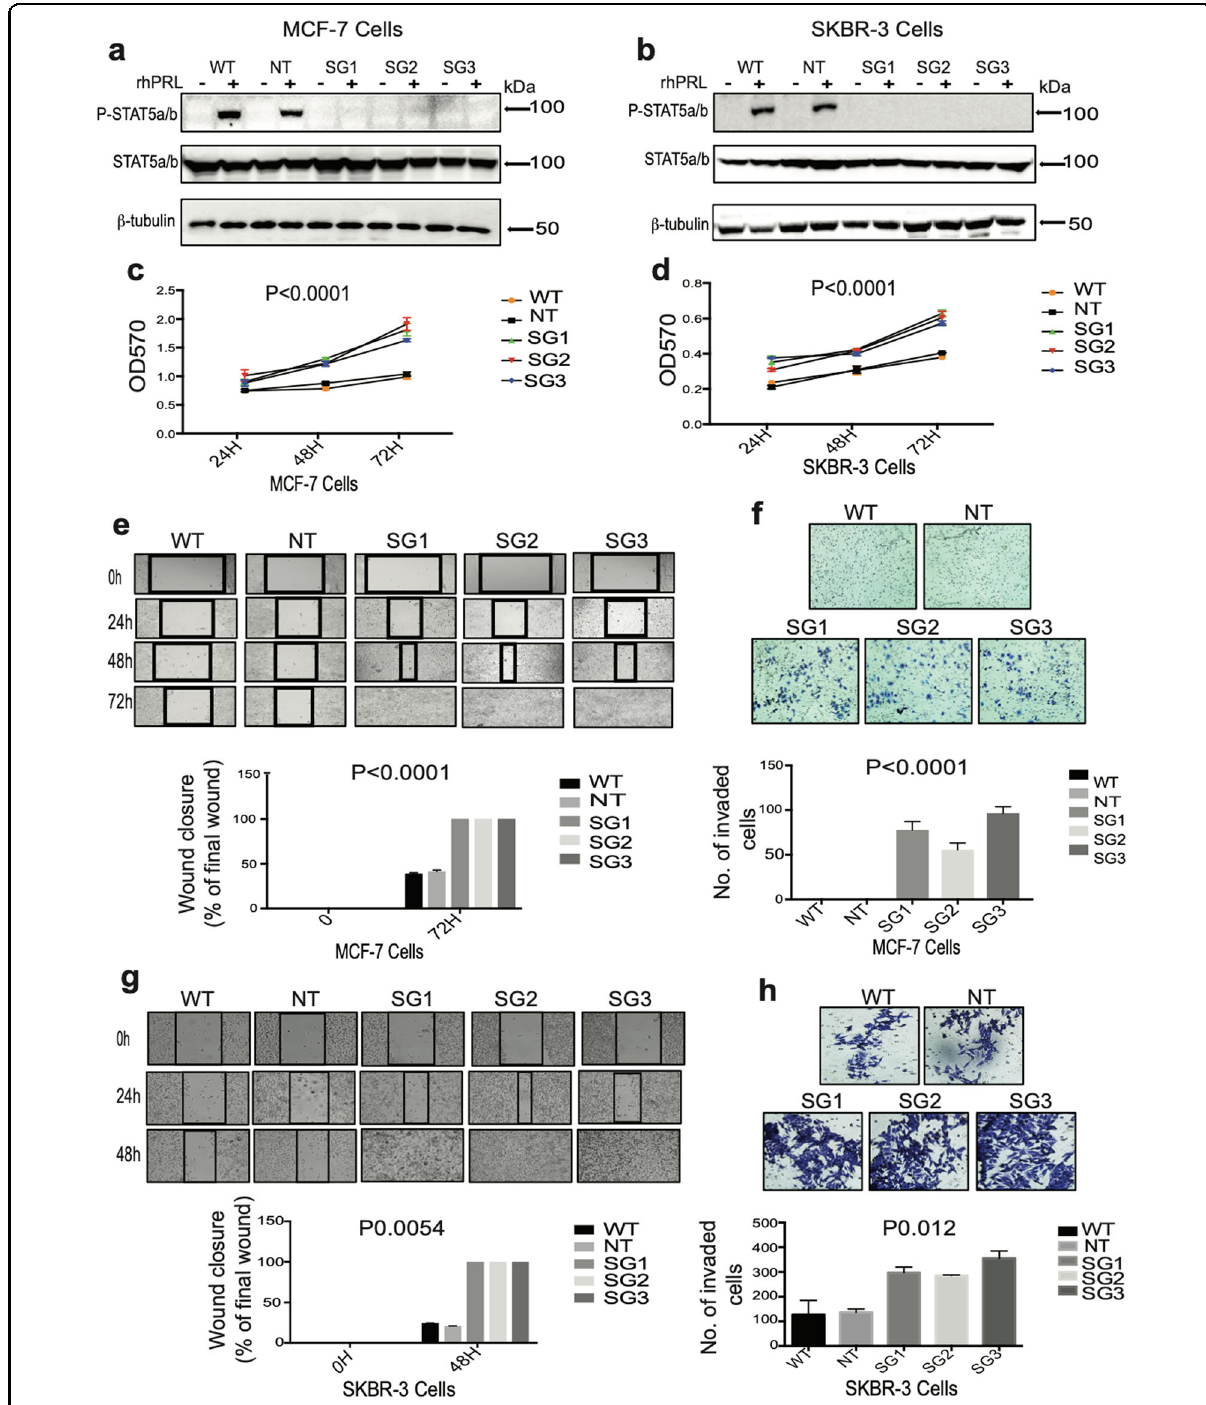
Fig. 1 (See legend on next